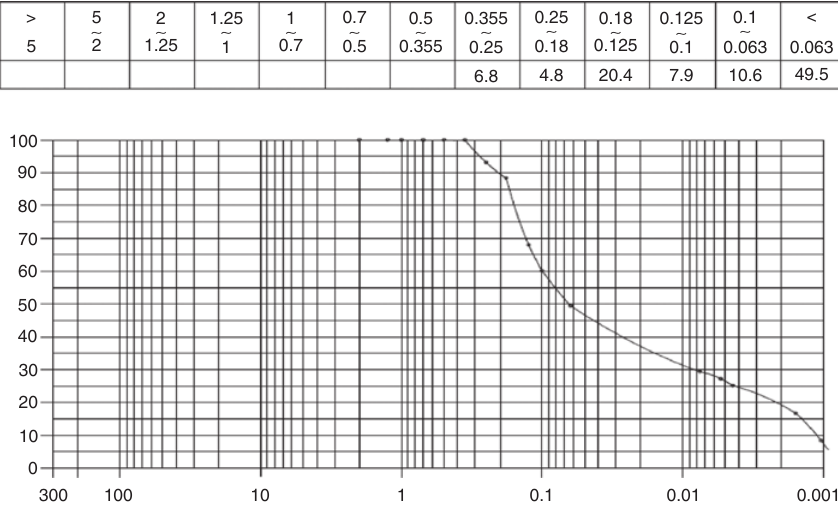
Cr O (artificial 2 2 7